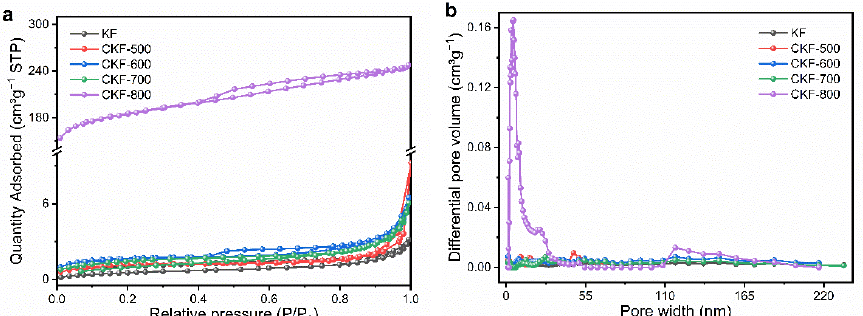
Figure 4. ( a ) Nitrogen adsorption–desorption isotherms and ( b ) corresponding pore size distributions of KF and CKF fabricated under different carbonization temperatures.